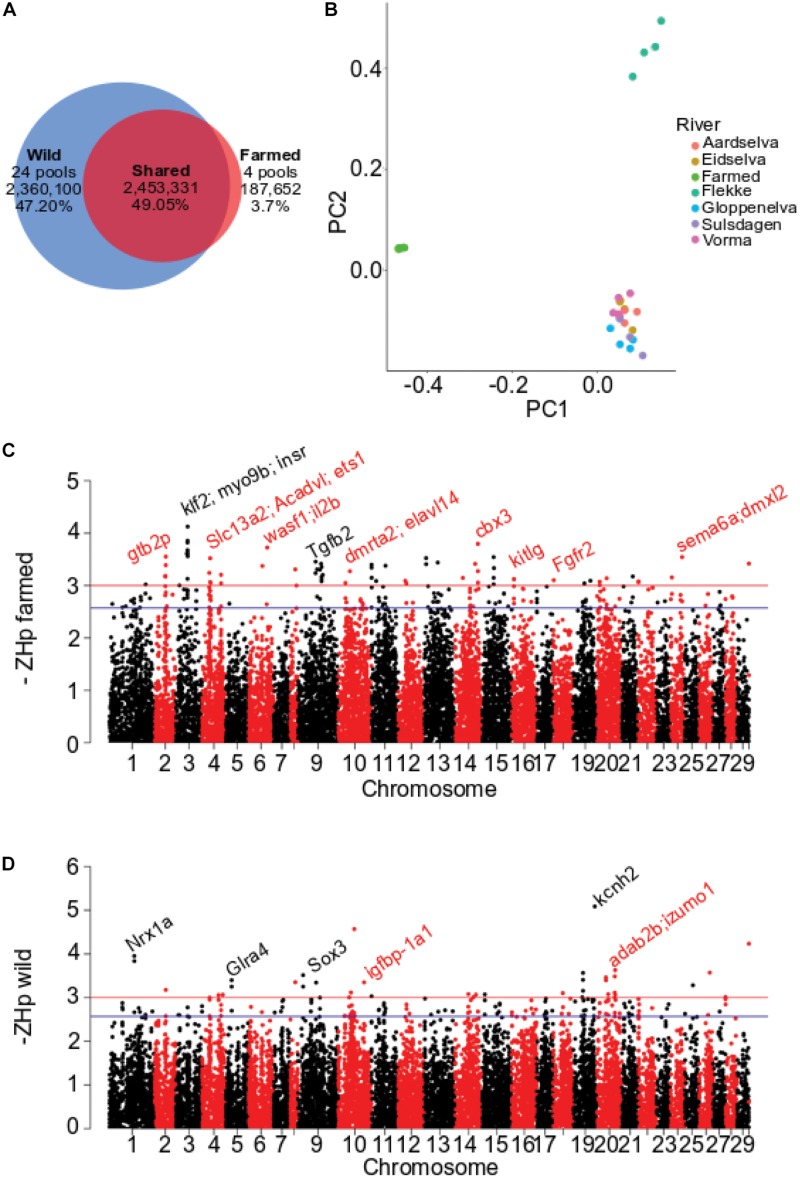
Distribution of pooled heterozygosity (ZHp) for Dataset 1. (A) Number and proportion of SNP shared between farmed and wild European Atlantic salmon. (B) Genomic relationship assessed using PCA of 28 pooled samples in Dataset1. PC1 explains 1.59% and PC2 1.13% of total variability. (C) Genome-wide plot of -ZHp estimated for farmed fish. (D) Genome-wide plot of -ZHp estimated for farmed fish.